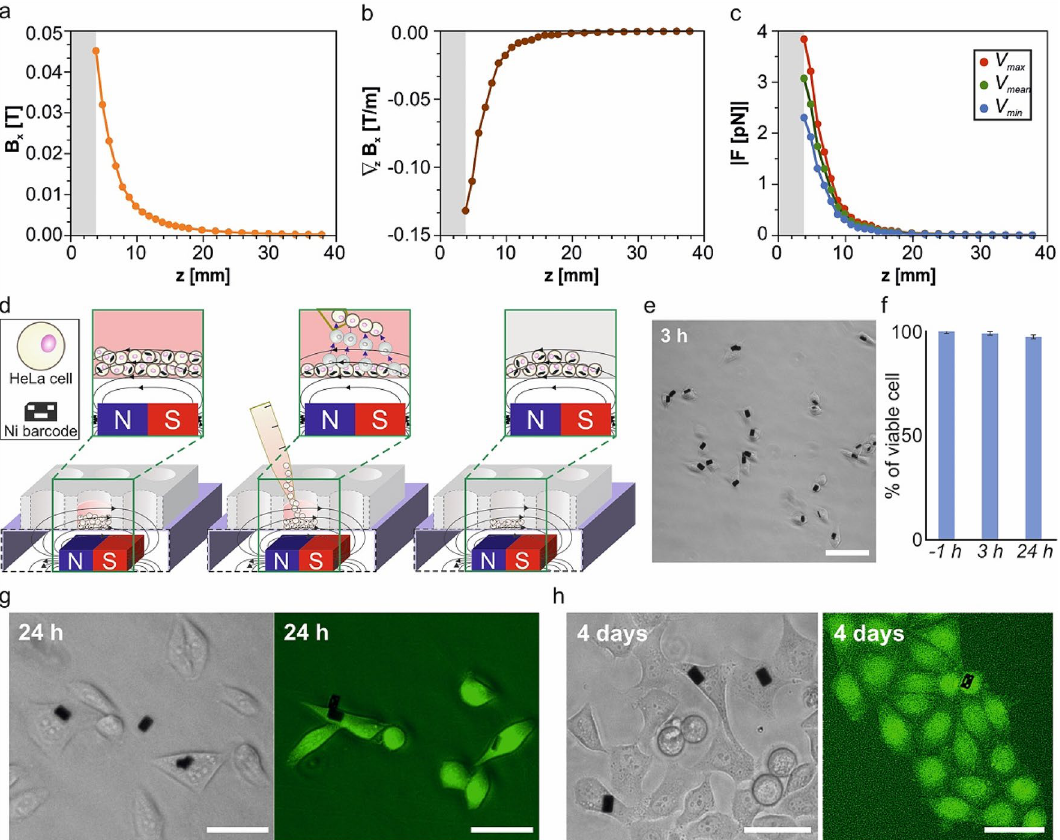
Figure 4. Magnetic trapping of the subpopulation of HeLa cells with internalized Ni barcodes. ( a ) Measured magnetic field, B x , of the magnet and ( b ) the calculated gradient of magnetic field, ∇ z B x , versus the distance to the magnet, z . ( c ) Estimated force, F , applied over the Ni devices (assuming magnetic saturation) depending on the distance to the magnet for the maximum, mean and minimum barcode volumes. Measurements for Hall probe-magnet distances below 3.81 mm (grey area) were not possible to carried out due to the position of the Hall sensor inside the probe. ( d ) Schematic representation of the cell separation process. (left) A magnet was placed close to the bottom (4.9 mm) of the well containing the cell suspension. After a 15 s exposure, cells with internalized magnetic barcodes are retained and trapped, named positive selection, and cells without a device could be transferred to another well (center), thus enriching the cell population with internalized Ni barcode that remains in the first well. ( e ) Optical image of HeLa cells 3 h after magnetic separation. ( f ) Viability of cells cultured with Ni barcode before (− 1 h) and after (3 h and 24 h) magnetic separation. Percentage values were obtained by analyzing between 300 and 1000 cells for each condition, mean and SD, n = 4. ( g ) and ( h ) Optical and EFM images of HeLa cells stained with 2 µM calcein-AM (green fluorescence) 24 h and 4 days after magnetic separation, respectively, to assess cell viability. Scale bars: 40